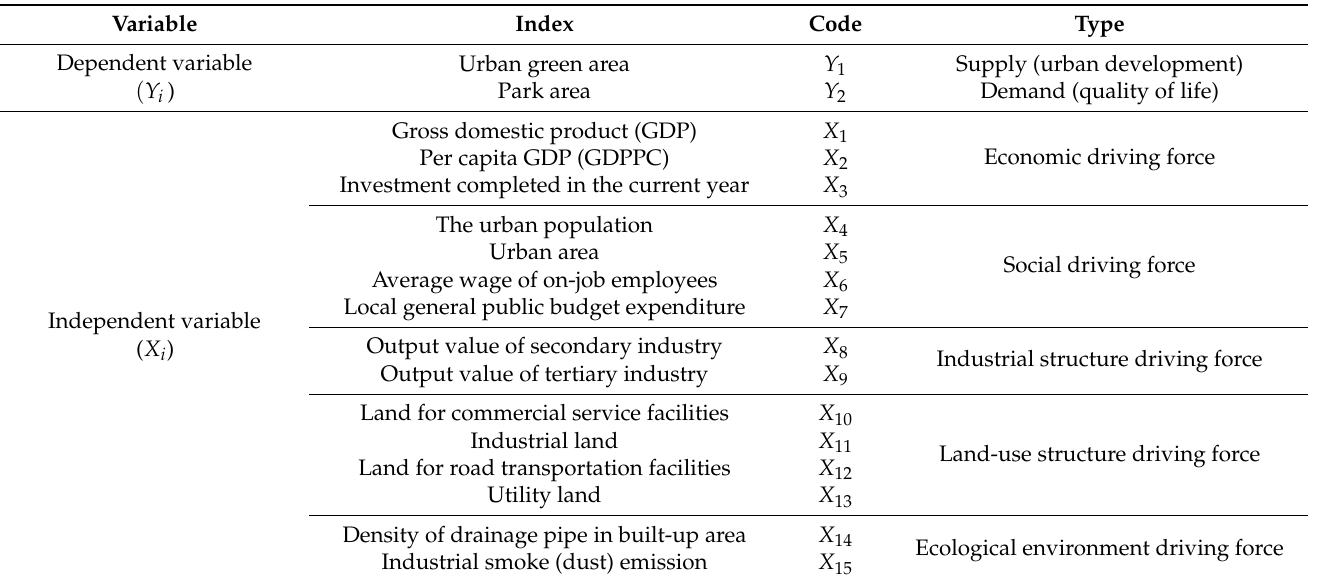
Table 3. Model variable